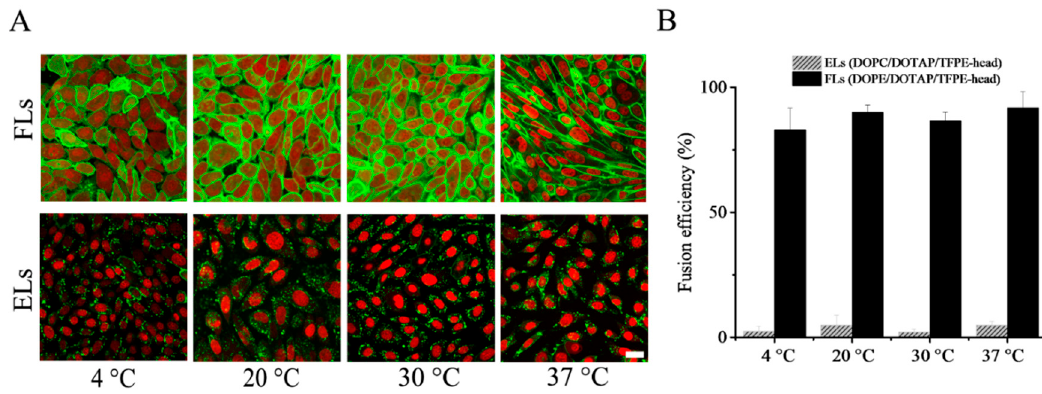
Figure 2. ( A ) Fluorescence micrographs of CHO cells treated with fusogenic liposomes (FLs) DOPE/DOTAP/TFPE-head (1/1/0.1 mol/mol), upper row, and endocytic liposomes (ELs) DOPC/DOTAP/TFPE-head (1/1/0.1 mol/mol), lower row. Green: TFPE-head signal, red: Nuclei staining with DRAQ5. Scale bar, 20 µm, applies to all. Experiments were done in PBS buffer. ( B ) Fusion efficiencies. Whiskers indicate standard deviations of at least three independent experiments. In total, more than 1500 cells were analyzed at each condition.